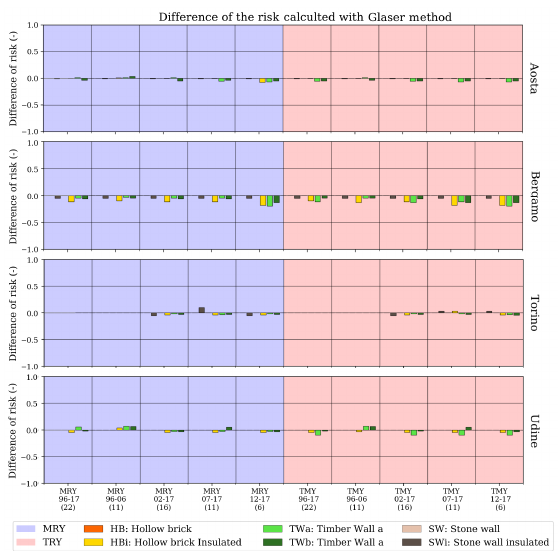
Figure 10. Evaluation of the representative years in terms of moisture accumulation risk calculated with the Glaser method for the considered stations. The differences of risk are calculated between the representative years risk and the full multi-year record result. The background is blue for the Moisture Representative Years (MRY) and red for the Typical Meteorological Years